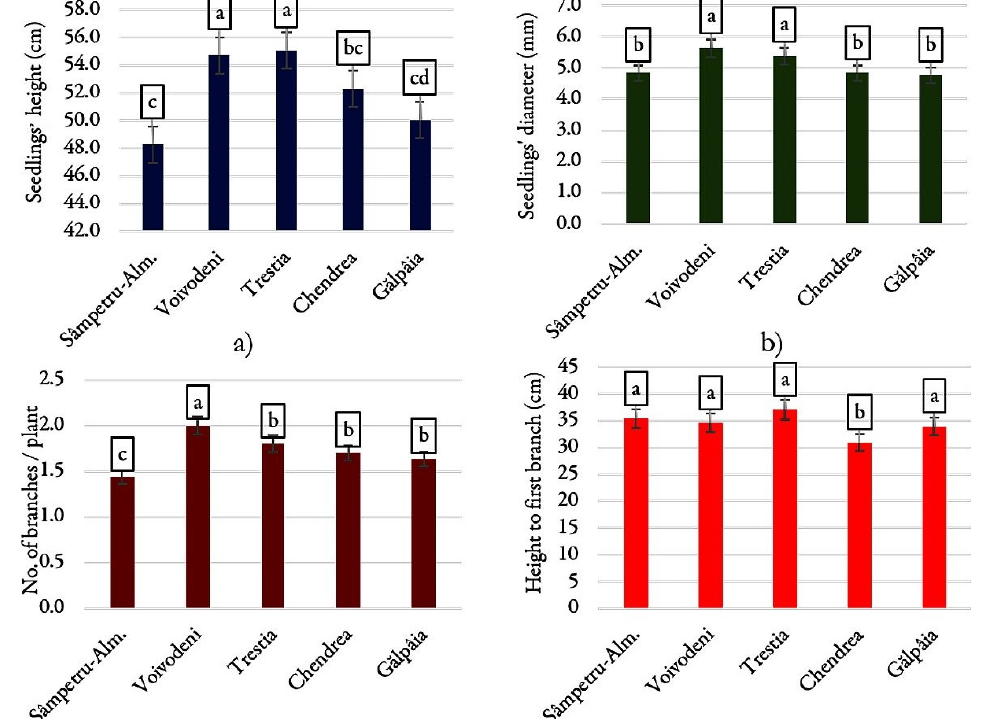
Figure 7. The main characteristics of seedlings at the end of the first year of vegetation, depending on the origin stand: a) Seedlings height (cm); b) Seedlings diameter (mm); c) Number of branches/seedlings; d) Height to the first branch (cm), as mean ±